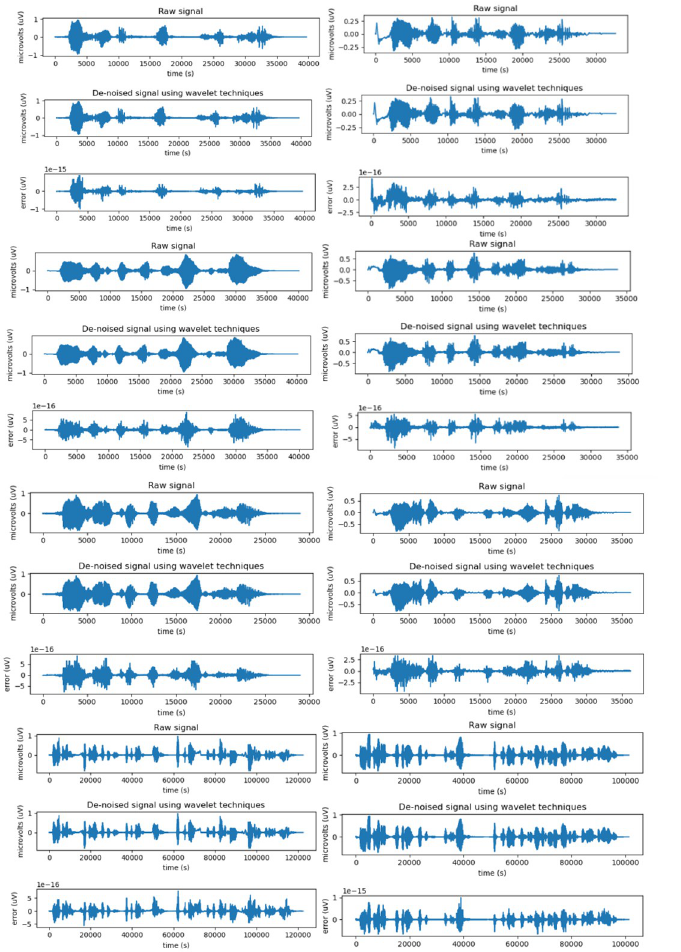
Fig 7. Experimental waveform comparison